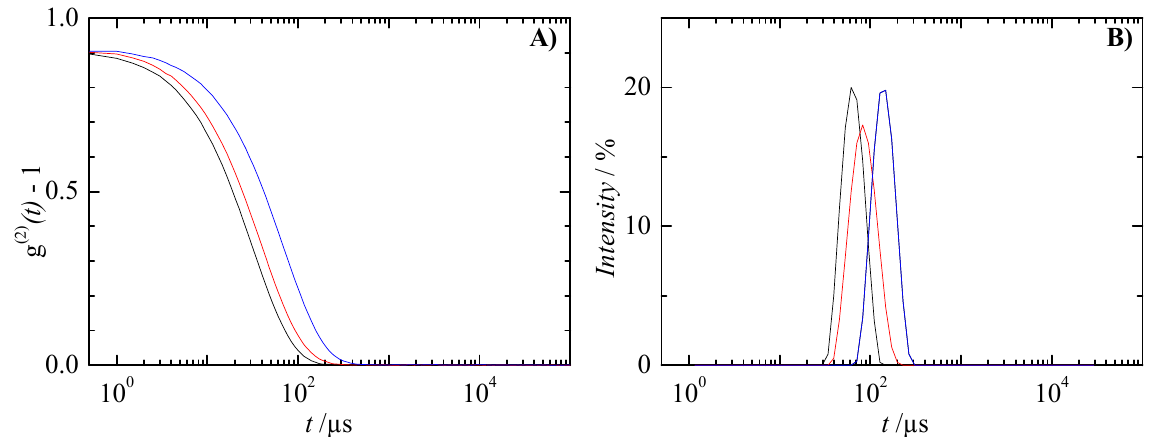
Figure 3. DLS study of different O/W microemulsions with different emulsifier (surfactant/co-surfactant mixture) concentrations and a fixed Akypo/2-propanol ratio of 1/2 (the oil content remains constant at 3% w / w ): ( A ) Autocorrelation functions of intensities. ( B ) Intensity distributions. The different plots correspond to O/W microemulsions with different concentrations of the surfactant/co-surfactant mixture: ( ―) 48% w / w , ( ― ) 44% w / w, and ( ― ) 41% w / w .